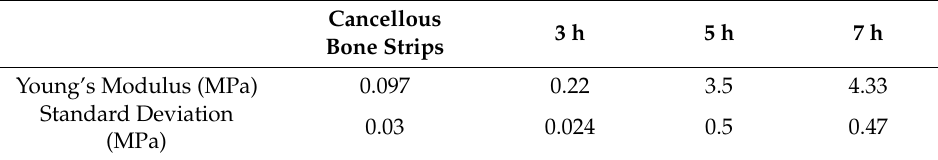
Table 2. Young’s modulus of the heat-treated samples and cancellous bone